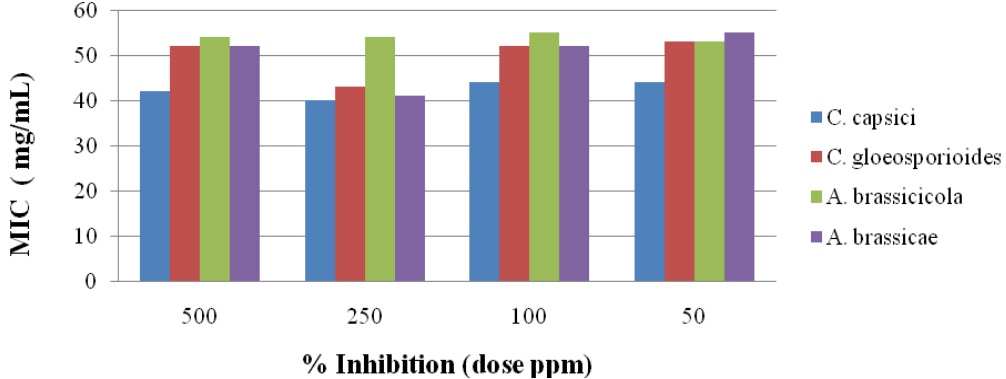
Positive control: fluconazole; negative control: